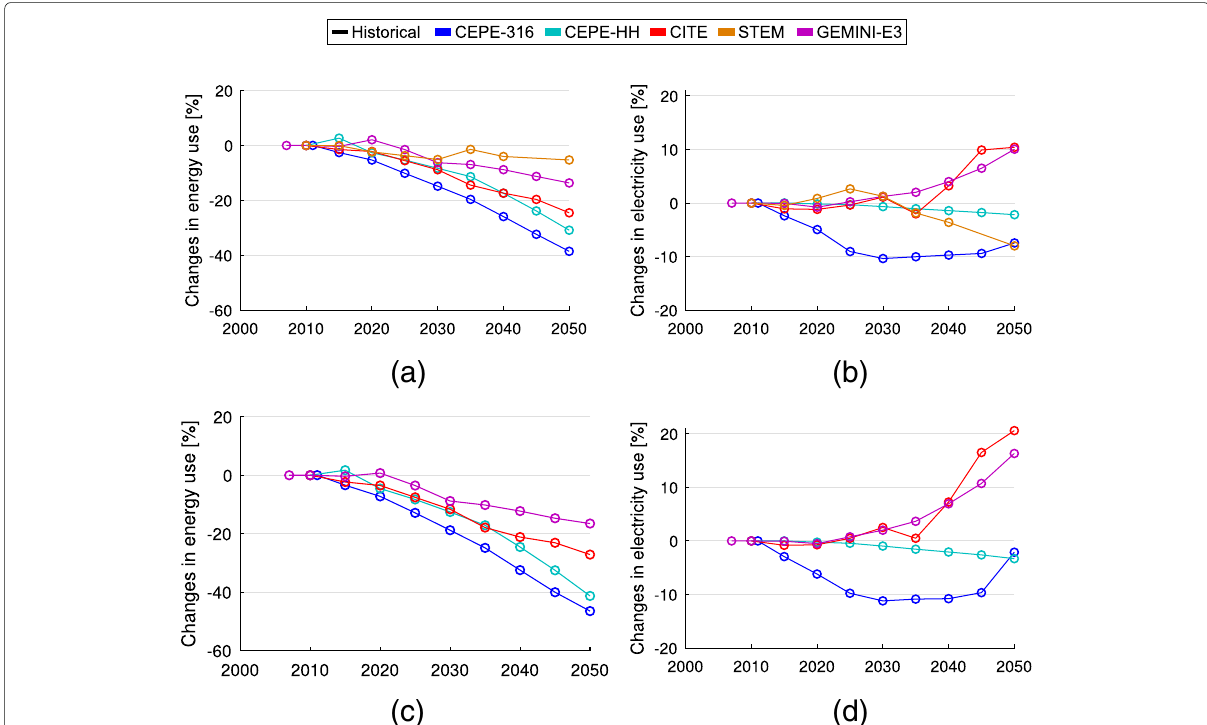
Fig. 2 Changes in final energy and electricity use compared to BAU. a Final energy: 1.5_uni . b Electricity: 1.5_uni . c Final energy: 1.0_uni . d Electricity: